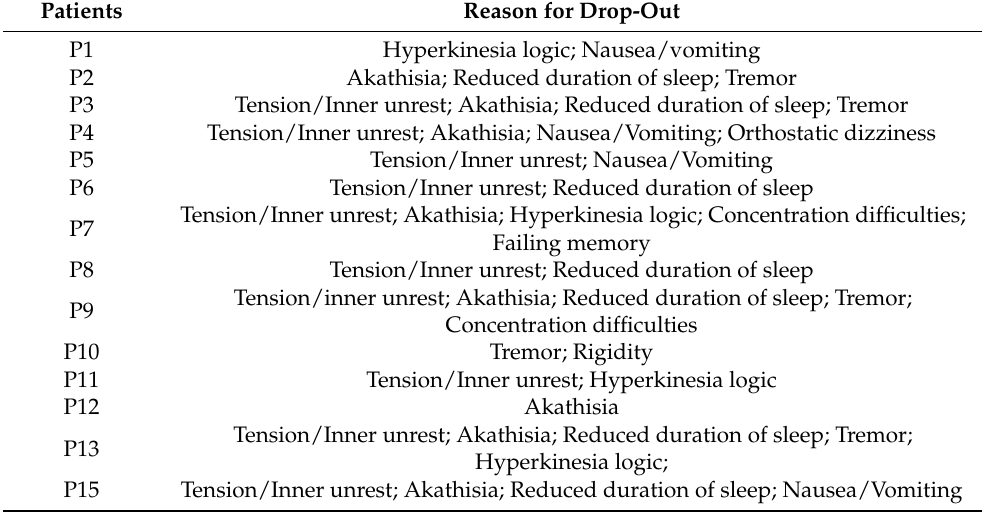
Table 2. Adverse events leading to